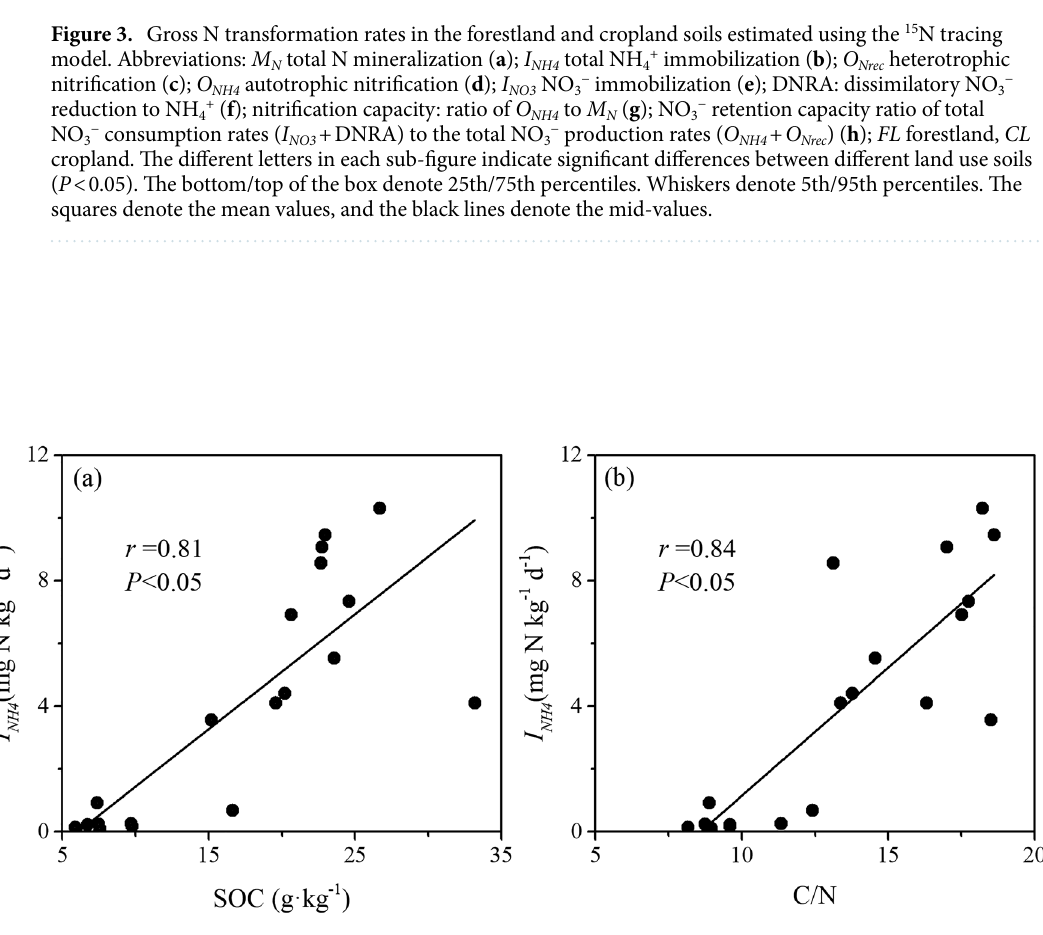
Figure 4. Relationships between soil gross NH 4+ immobilization rates and SOC content ( a ) and C/N ratio ( b